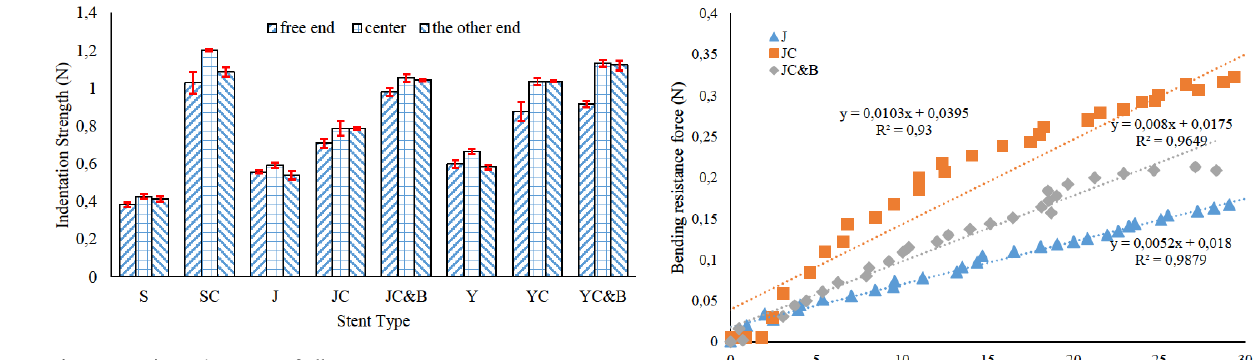
Figure 5: Indentation tests of all stems.